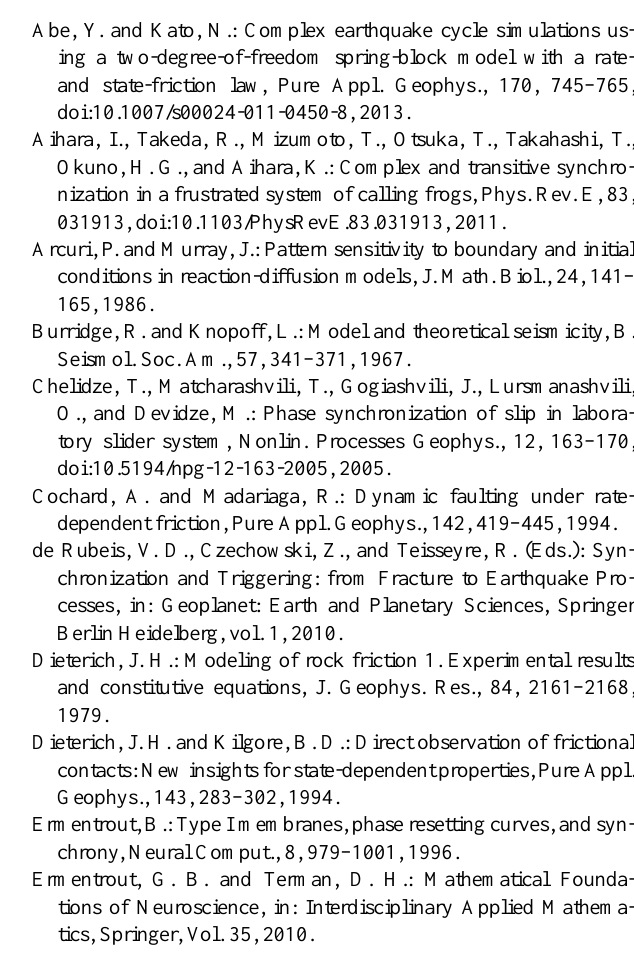
Fig. C1. A comparison of the orbits, graphs of (cid:0) θV p /L,V/V p (cid:1) , in a double logarithmic plane. The red curve, green dots, and blue tri- angles are the orbits of the original limit cycle, oscillators 1 and 2 in case 3,